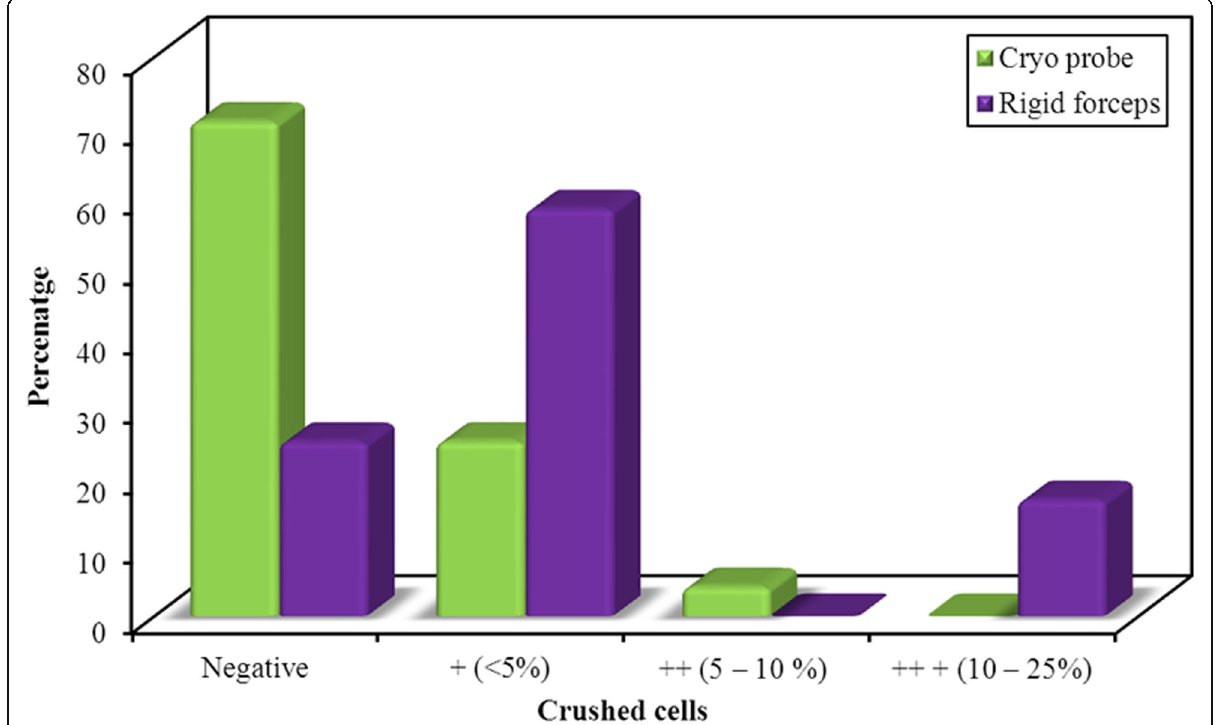
Fig. 4 Comparison between cryoprobe and rigid forceps according to crushed cells ( n =